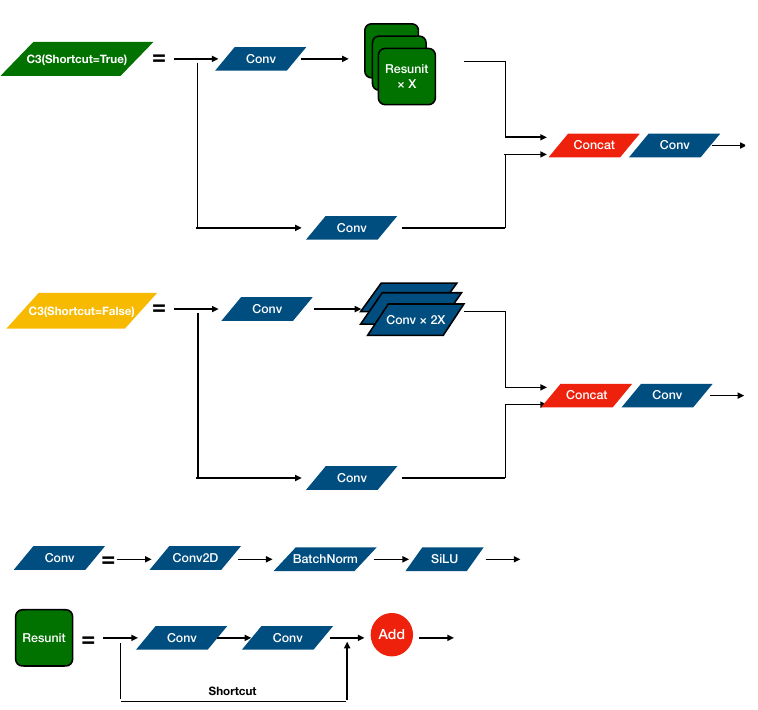
Figure 2. The structure of the CONV unit module and C3 unit module. The green C3 unit contains multiple Resunit with shortcut structures applied in the backbone network. The yellow C3 unit without a shortcut structure is applied in the neck network. The Conv2D refers to 2D convolution. The BachNorm refers to batch normalization.